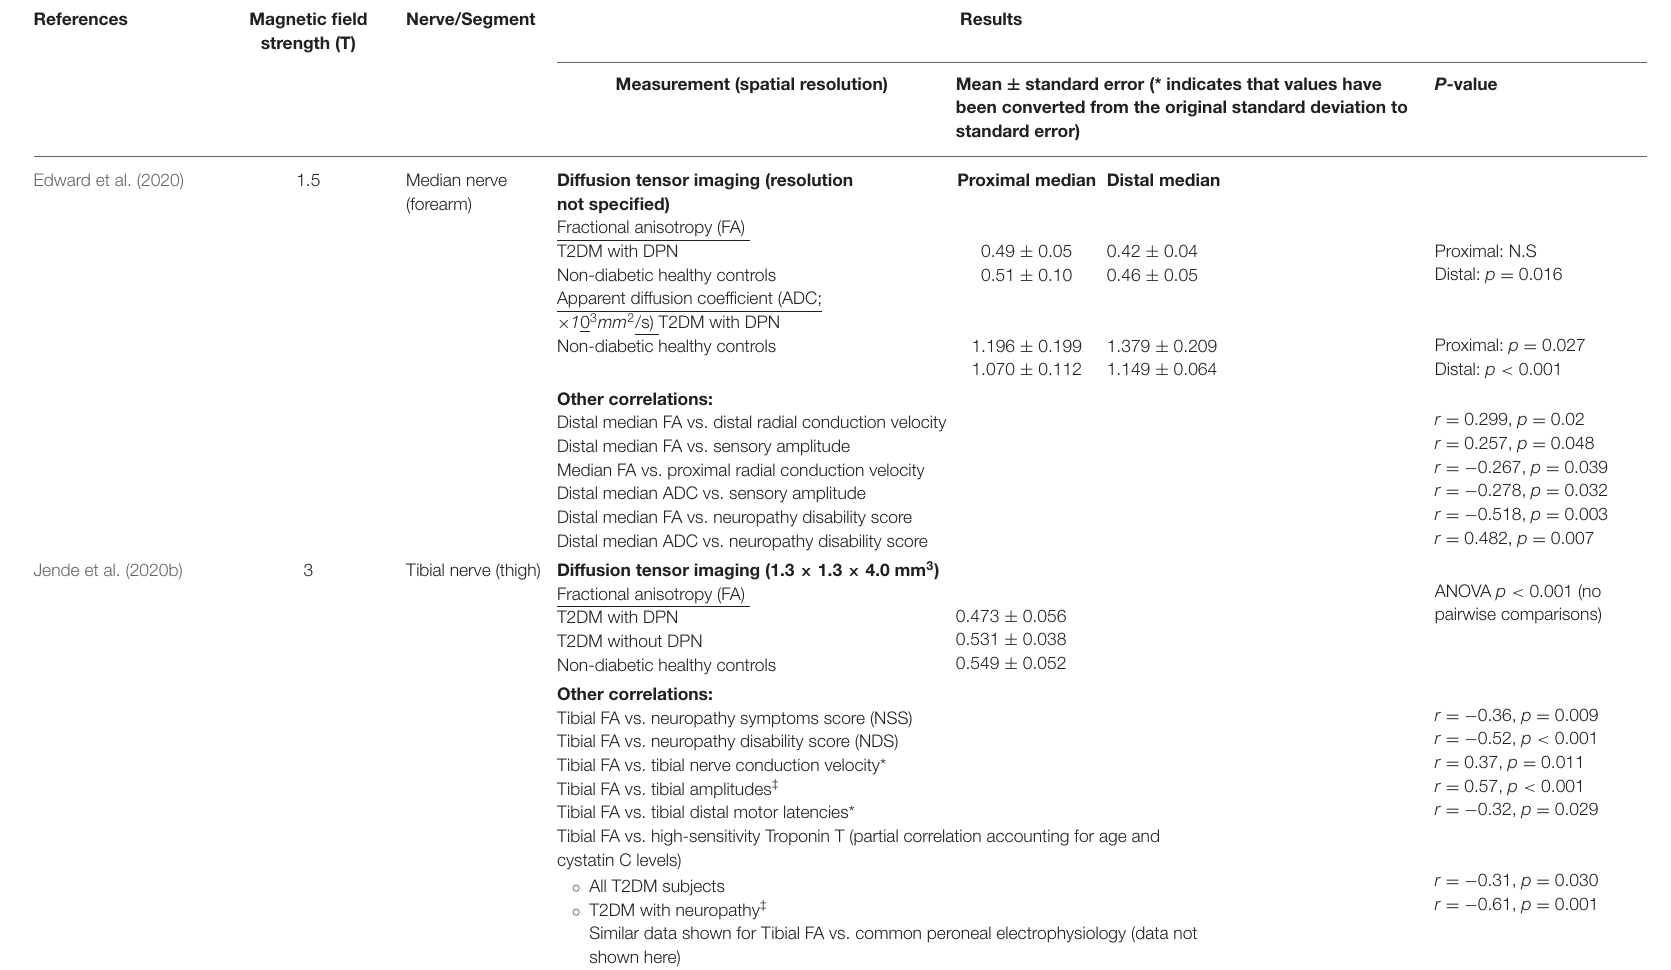
Other correlations: Tibial FA vs. neuropathy symptoms score (NSS) Tibial FA vs. neuropathy disability score (NDS) Tibial FA vs. tibial nerve conduction velocity* Tibial FA vs. tibial amplitudes ‡ Tibial FA vs. tibial distal motor latencies* Tibial FA vs. high-sensitivity Troponin T (partial correlation accounting for age and cystatin C levels) ◦ All T2DM subjects ◦ T2DM with neuropathy ‡ Similar data shown for Tibial FA vs. common peroneal electrophysiology (data not shown